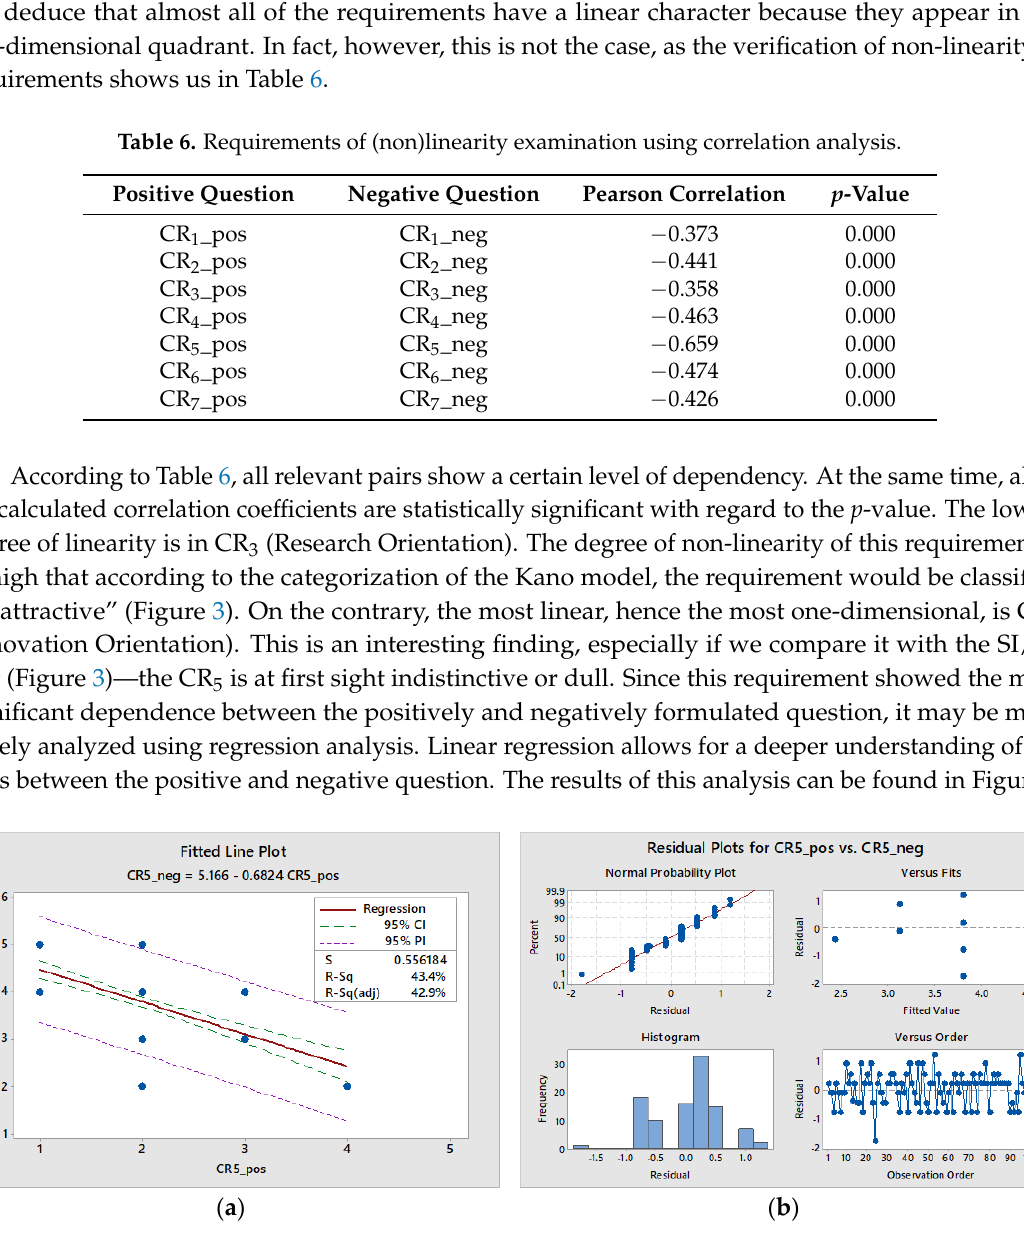
Figure 5. Regression analysis; ( a ) fitted linear model; ( b ) residual analysis.